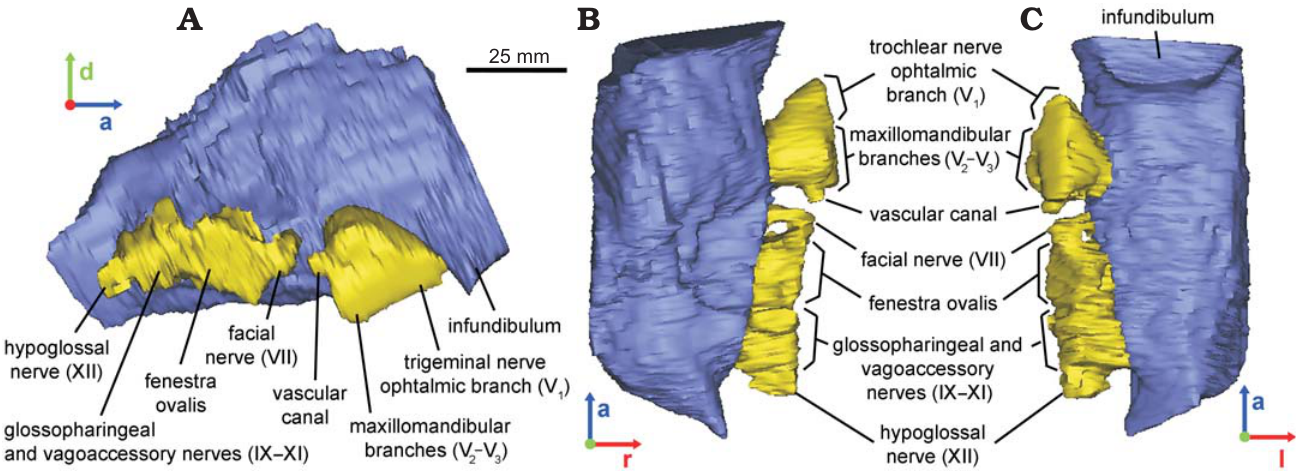
Fig. 5. Reconstructed endocast of braincase of the hadrosaurid dinosaur Secernosaurus koerneri Brett-Surman, 1979 (MACN-RN 143) from the late Campanian–early Maastrichtian, Los Alamitos Formation of North Patagonia; in lateral right ( A ), dorsal ( B ), and ventral ( C ) views. Blue, encephalon; yellow, foramina of the cranial nerves. Abbreviations: a, anterior; d, dorsal; l, left; r, right.